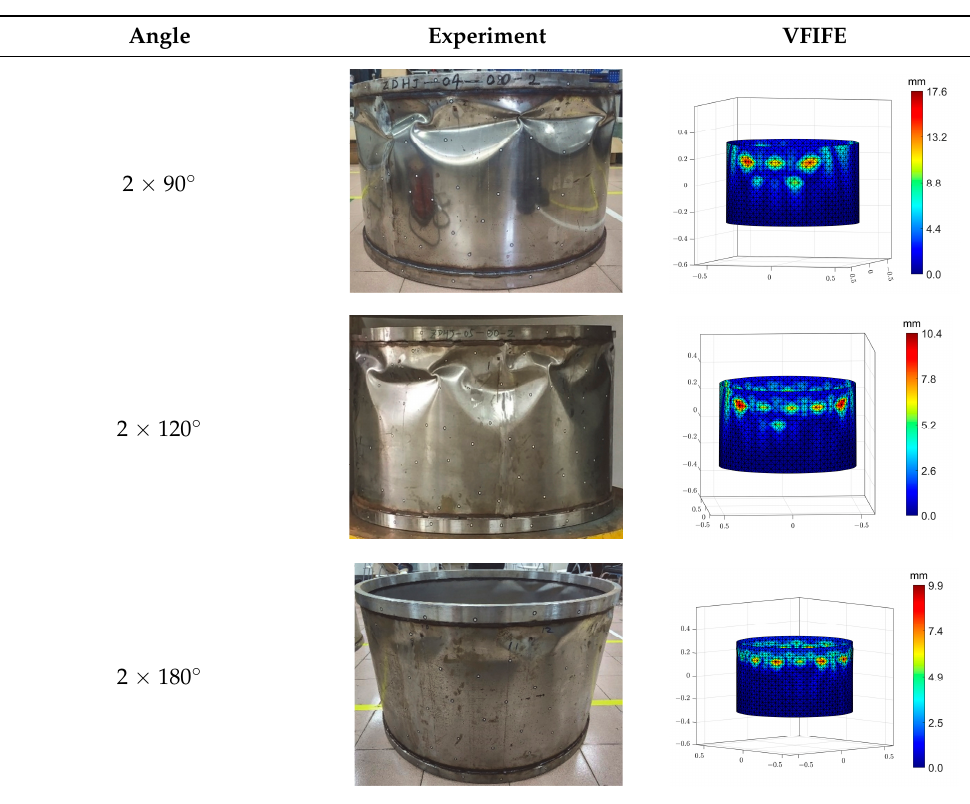
Table 3. Comparison of buckling mode. Pictures of the experiment are reproduced with the permis- sion of [12], copyright@Thin-Walled Structures, 2021.